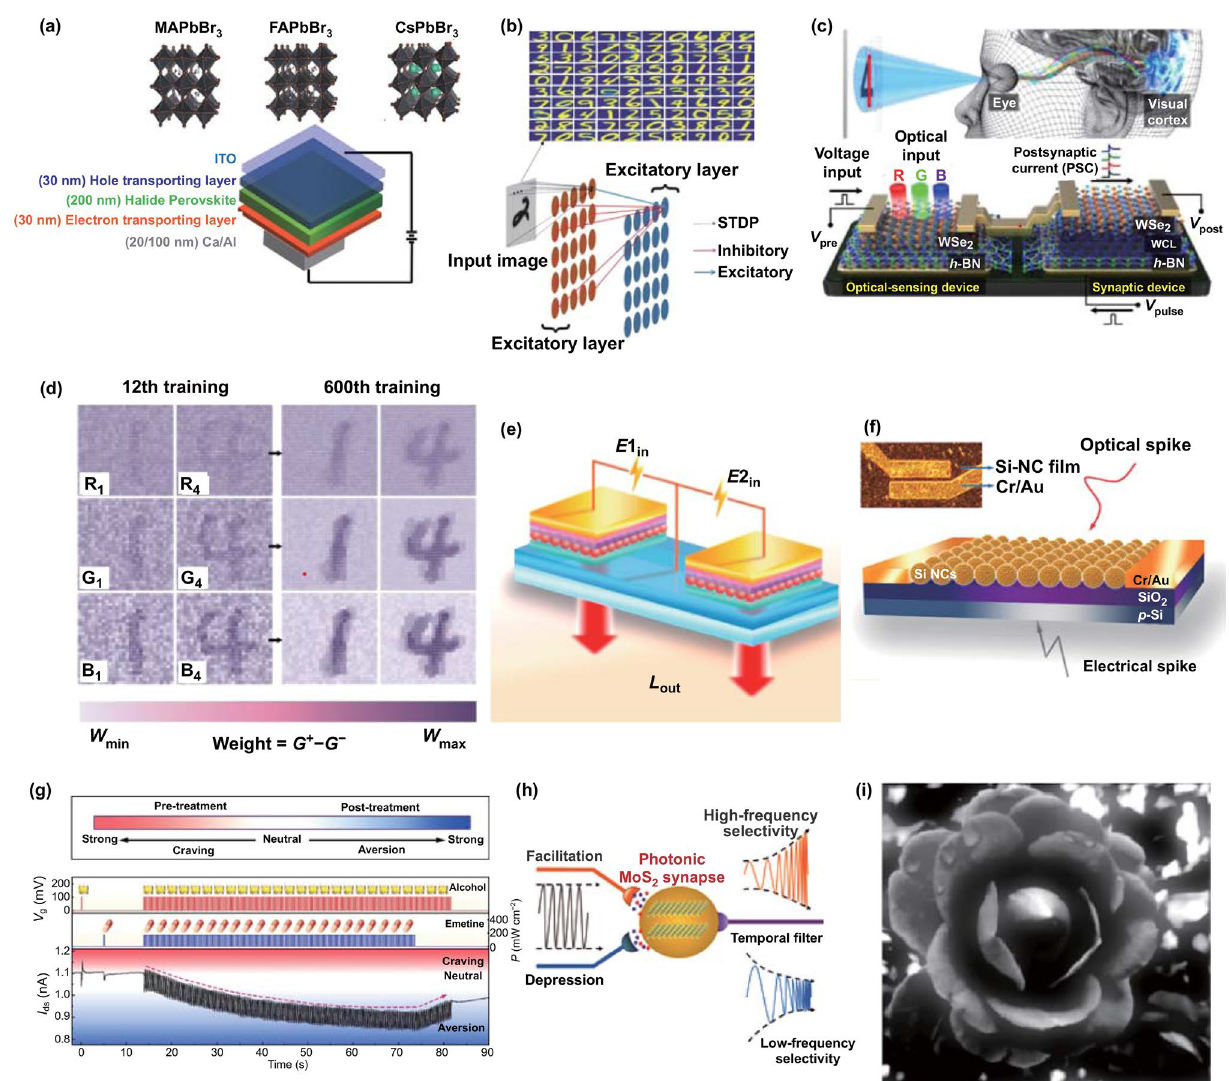
Fig. 10 a Synaptic devices based on halide perovskites, including MAPbBr 3 , FAPbBr 3 , and CsPbBr 3 . b Handwritten numeral recognition through the neural network based on synaptic devices. a , b Reproduced with permission from Ref. [143]. c A optic-neural synaptic device based on the h-BN/WSe 2 heterostructure. d Synaptic values change versus the increase of the training number. c , d Reproduced with permission from Ref. [91]. e Electroluminescent synaptic devices based on Si NCs. Reproduced with permission from Ref. [30]. f Si NC-based transistors syn- aptic device. g Aversion learning of the devices used for the treatment of people addicted to alcohol. f , g Reproduced with permission from Ref. [100]. h Photonic MoS 2 synapse as a temporal filter. Reproduced with permission from Ref. [102]. i Image of a flower after sharpening with a high-pass filter. Reproduced with permission from Ref.